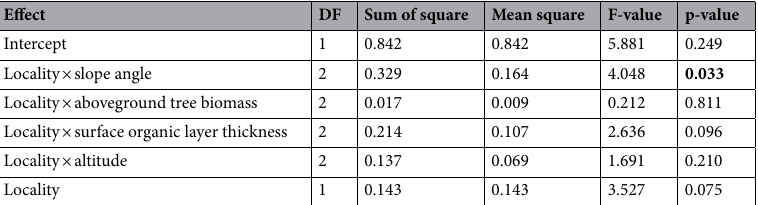
Table 2. Separate-slopes ANCOVA on the effect of locality as a random categorical factor on the cube root- transformed soil organic carbon concentration, adjusted for altitude, slope angle, aboveground tree biomass, and surface organic layer thickness. The locality factor represents geopedological characteristics pertaining to soil organic carbon at Bucharama and Malyj Orokan. Values rendered in bold are statistically significant at p < 0.05.